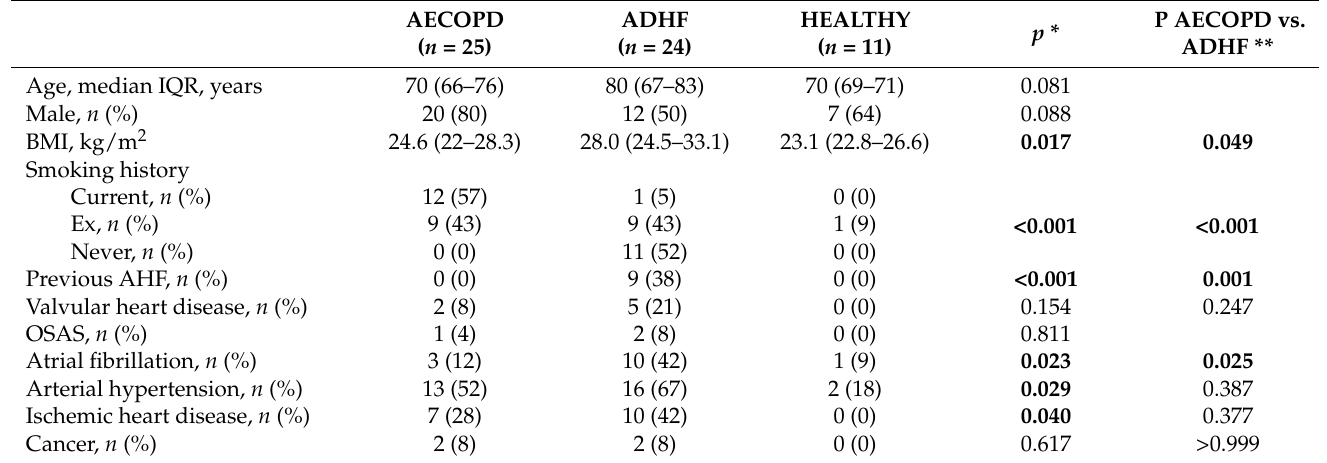
Table 1. Characteristics of enrolled patients and healthy